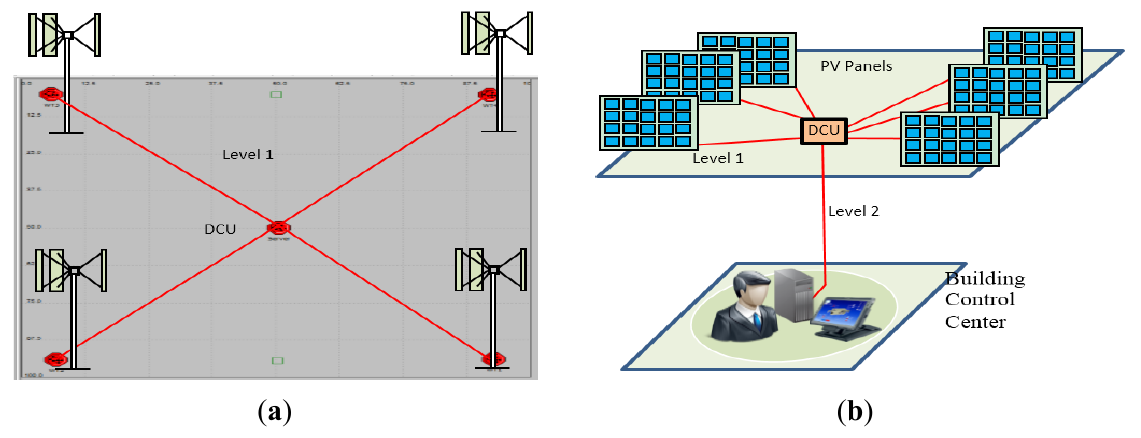
Figure 11. Network model for the smart-building ( a ) one-level wired network architecture; ( b ) Two-level Ethernet-based network architecture for the integration of PV systems.